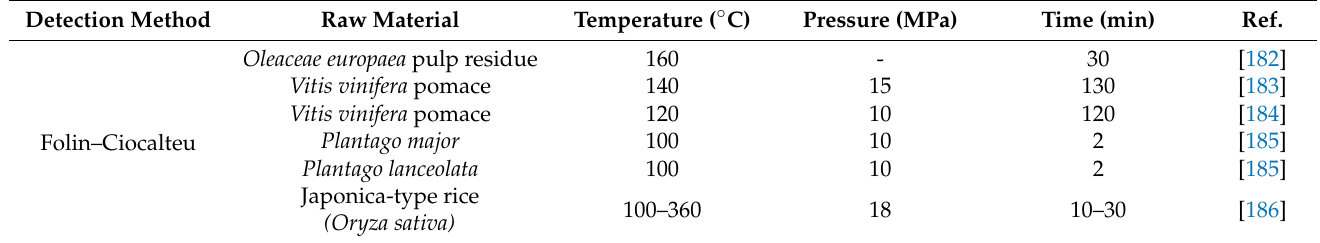
Table 13. Optimal extraction parameters by subcritical water extraction measured by Folin–Ciocalteu total phenolics assay. Literature reported in a review by Zhang et al. [181]. Detection Method Raw Material Temperature ( ◦ C) Pressure (MPa) Time (min)